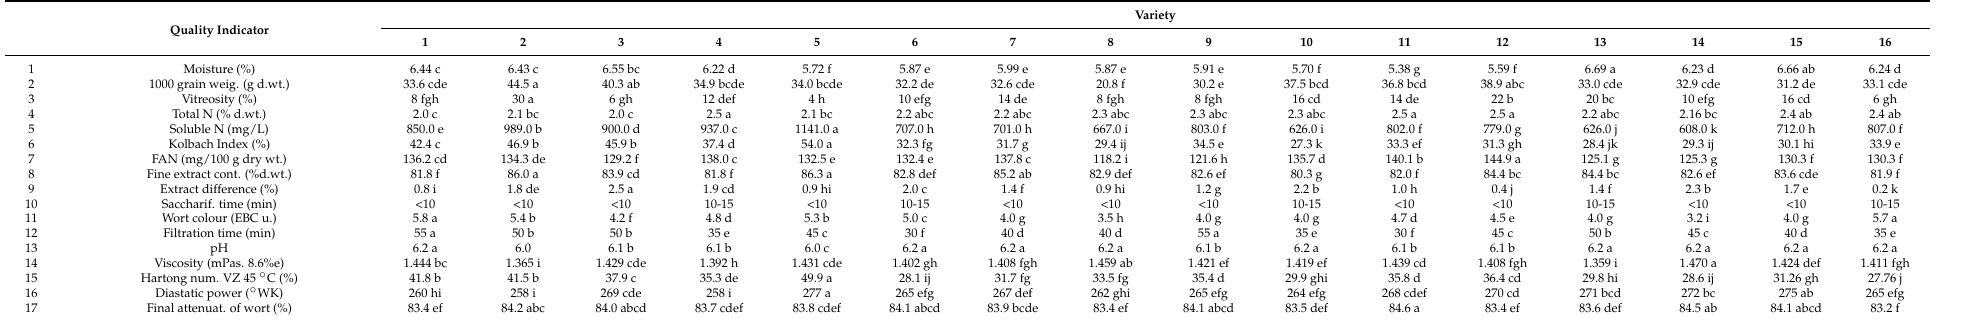
Finalattenuat. ofwort(%) Values are means of two measurements. Values displayed in the same lines and tagged with different letters are significantly different ( p <